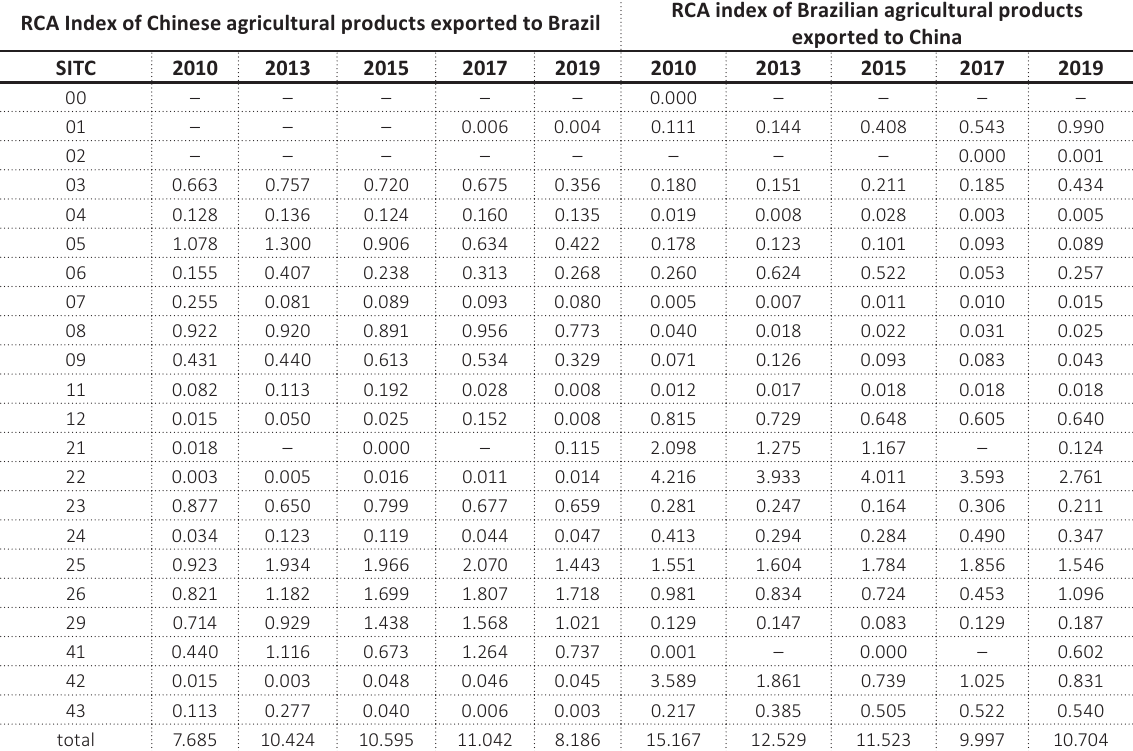
Table 2. Revealed comparative advantage index of China and Brazil’s agricultural exports RCA Index of Chinese agricultural products exported to